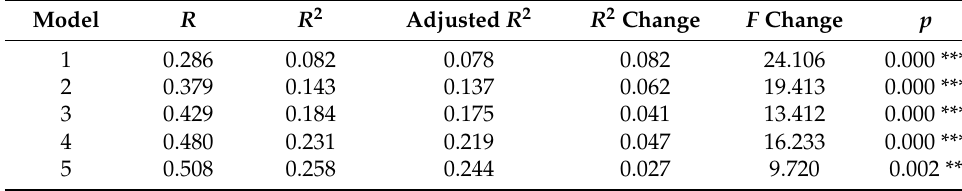
Table 2. Model summary for PTSD score: stepwise multiple regression analysis.